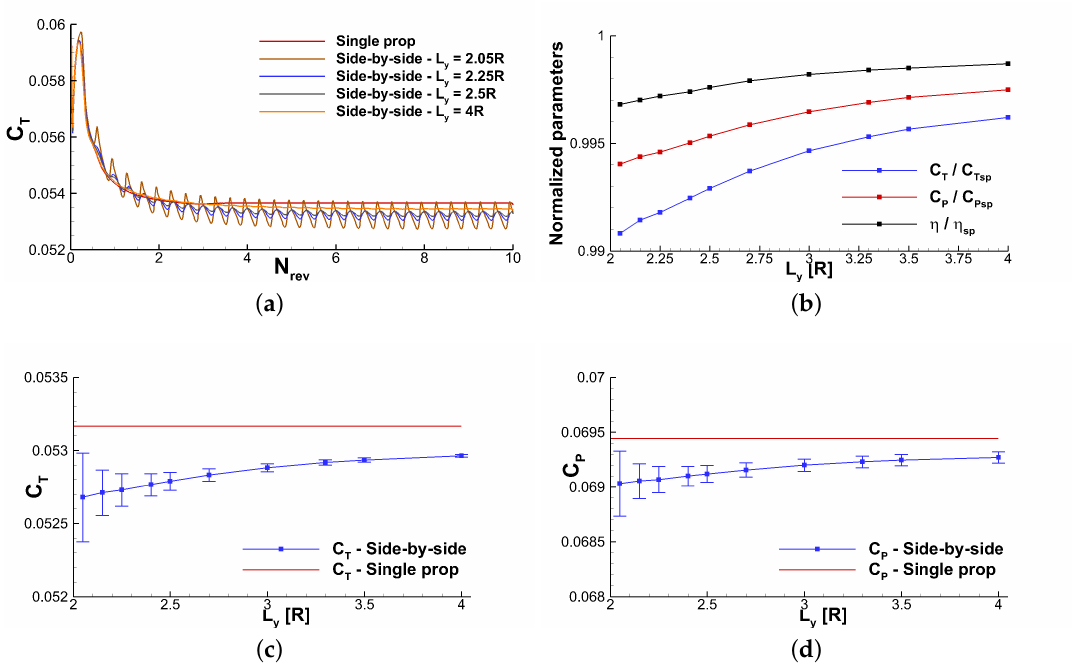
Figure 6. The results of the numerical simulations for the side-by-side interacting case, θ = 25.5 ◦ , M t = 0.32, J = 0.8. ( a ) Time histories of the thrust coefficient C T computed for the single propeller and for the counter-clockwise rotating propeller (upper propeller of Figure 5a) in side-by-side configuration at different lateral distances L y ; ( b ) normalised thrust coefficient C T , power coefficient C P and propulsive efficiency η with respect to the single propeller parameters as function of the lateral distance L y ; and, ( c , d ) averaged thrust coefficient C T and power coefficient C P as function of the lateral distance L y , errorbar corresponding to the standard deviation of the coefficients calculated over the last three rotor